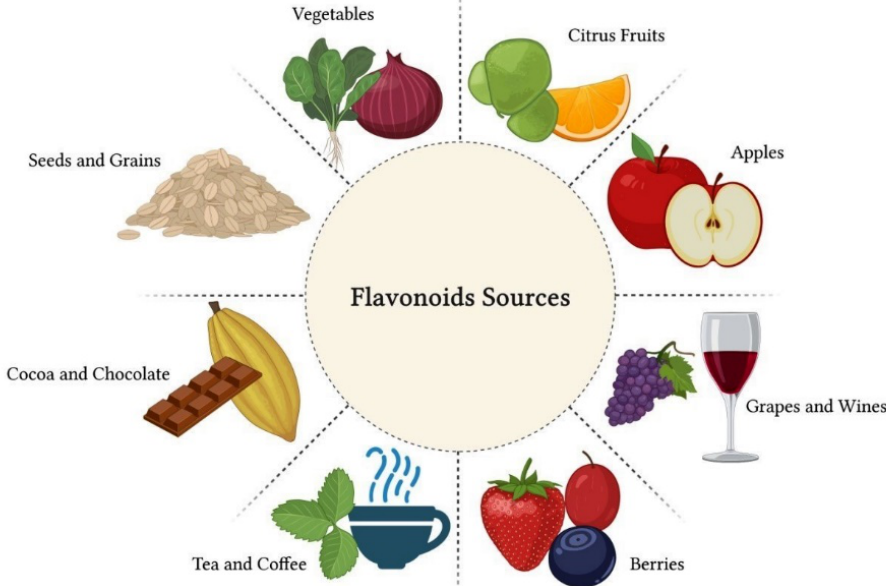
Figure 2. Flavonoids are polyphenolic compounds present in citrus fruits, grapes, raspberries, apples, vegetables, legumes and grains, as well as beverages, such as green tea, cocoa, coffee and red wine. These natural compounds have great nutritional value due to their therapeutic properties.